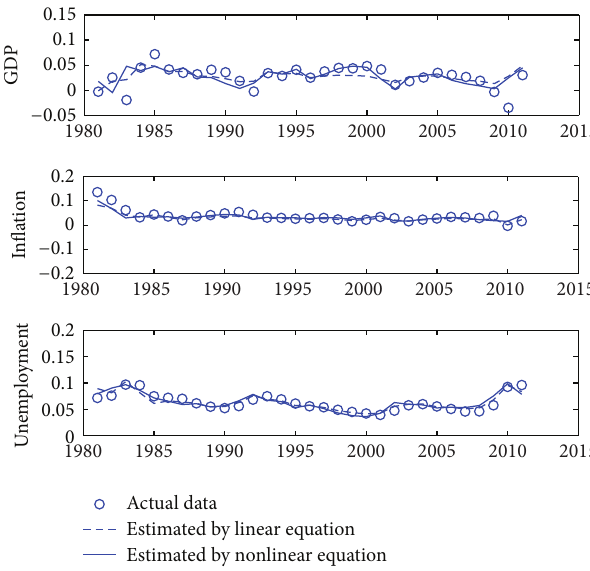
Figure 3: The actual and estimated data of the GDP, inflation, and unemployment by the linear and nonlinear models with ℎ = 0.75 .